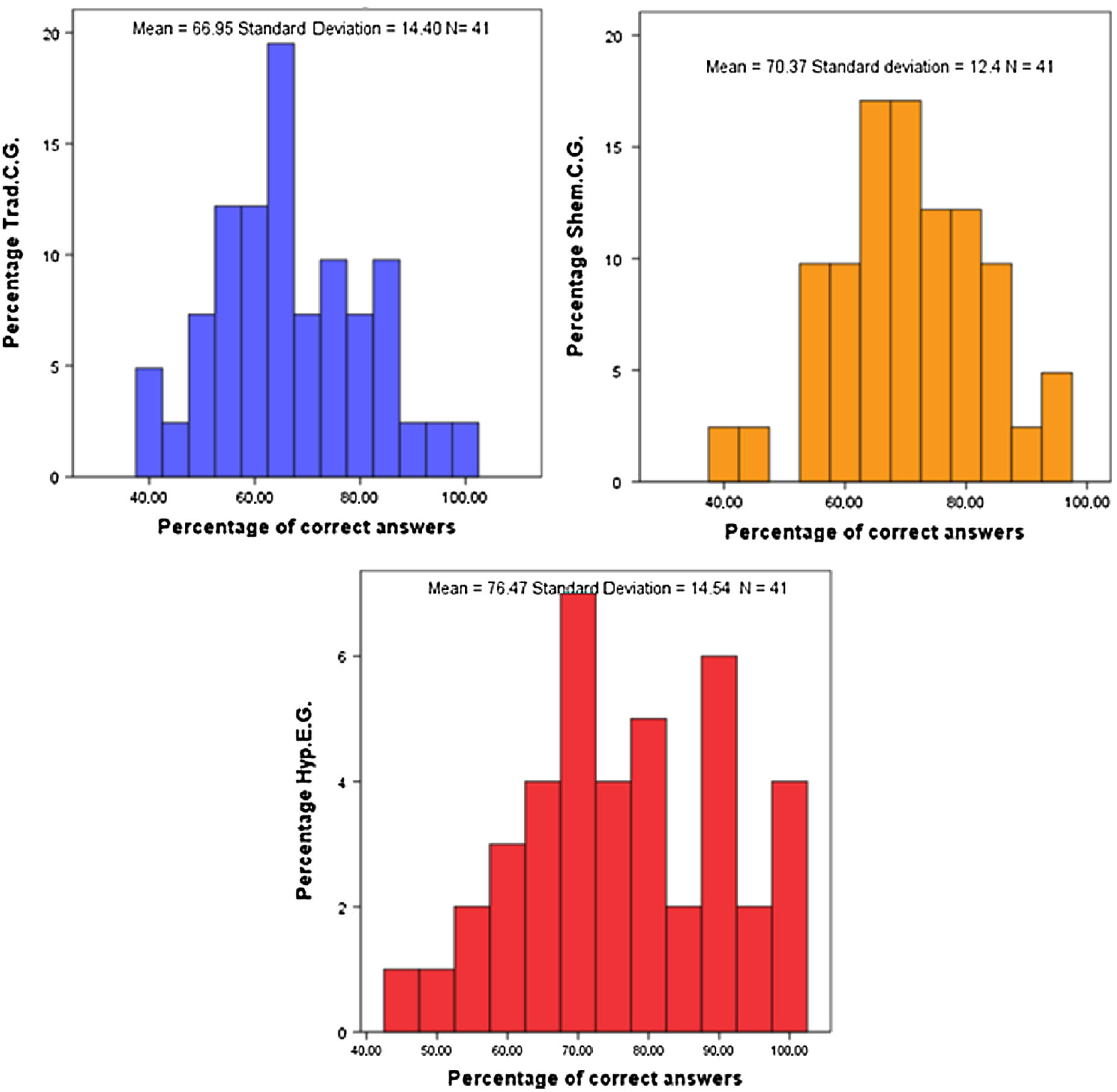
FIG. 7 (color online). Histogram of the percentage of correct answers for the Trad.C.G. (top left), the Schem.C.G. (top right), and the Hyp.E.G. (bottom) groups.